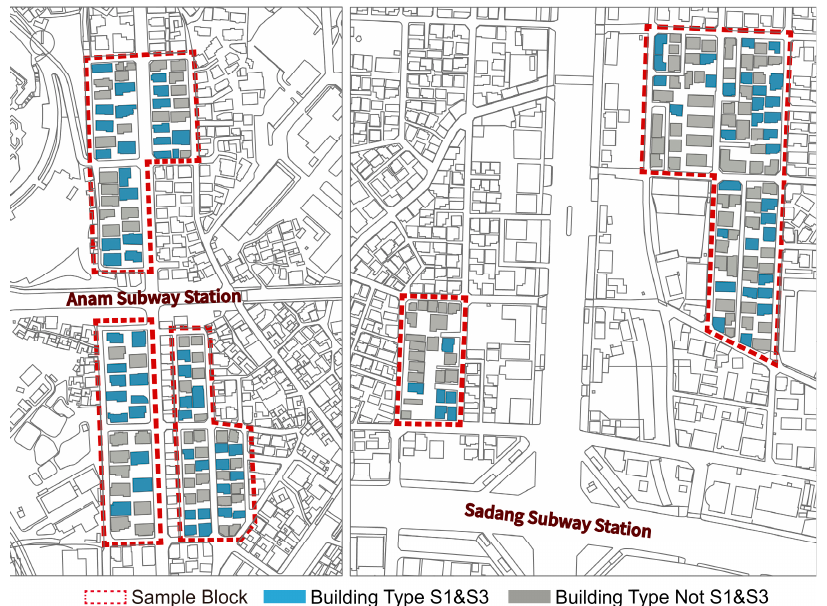
Figure 12. Distribution of massing types S1 and S3.